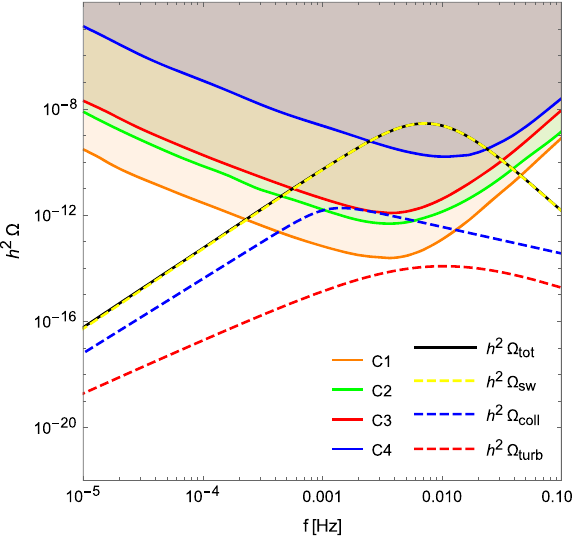
Fig. 6 GW spectra for the phase transition parameters (see Table 2). The black line denotes the total GW spectrum, the yellow line the con- tribution from sound waves, the blue line the contribution from bubble collisions, and the red line the contribution from turbulence. Sensitivity curves of the four configurations of eLISA detector (C1–C4) are also depicted [4]. The amplitude and peak frequency of phase transition GW spectrum fall within the observational window of eLISA